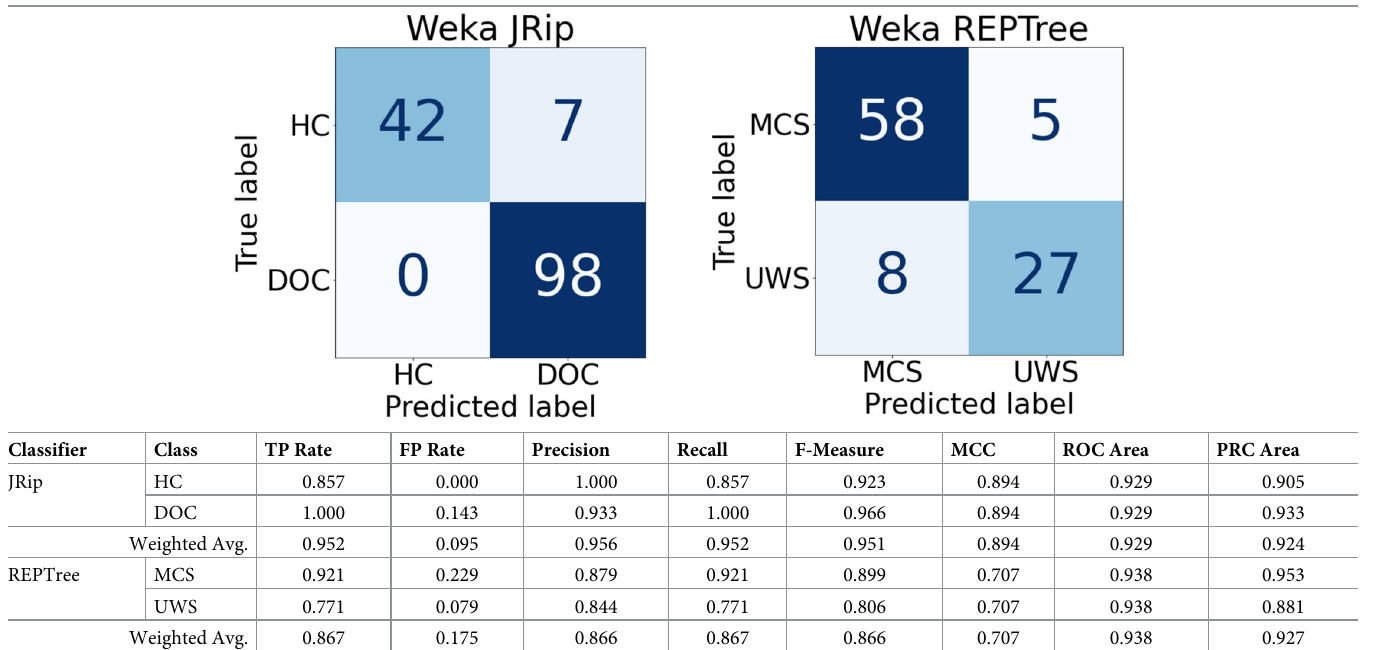
Table 2. Performance of the